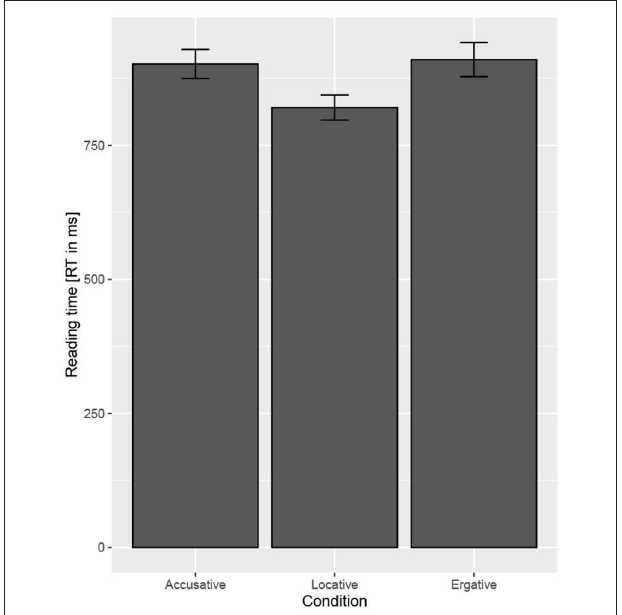
FIGURE 1 | Reading time at the post-critical region for the three conditions in Experiment